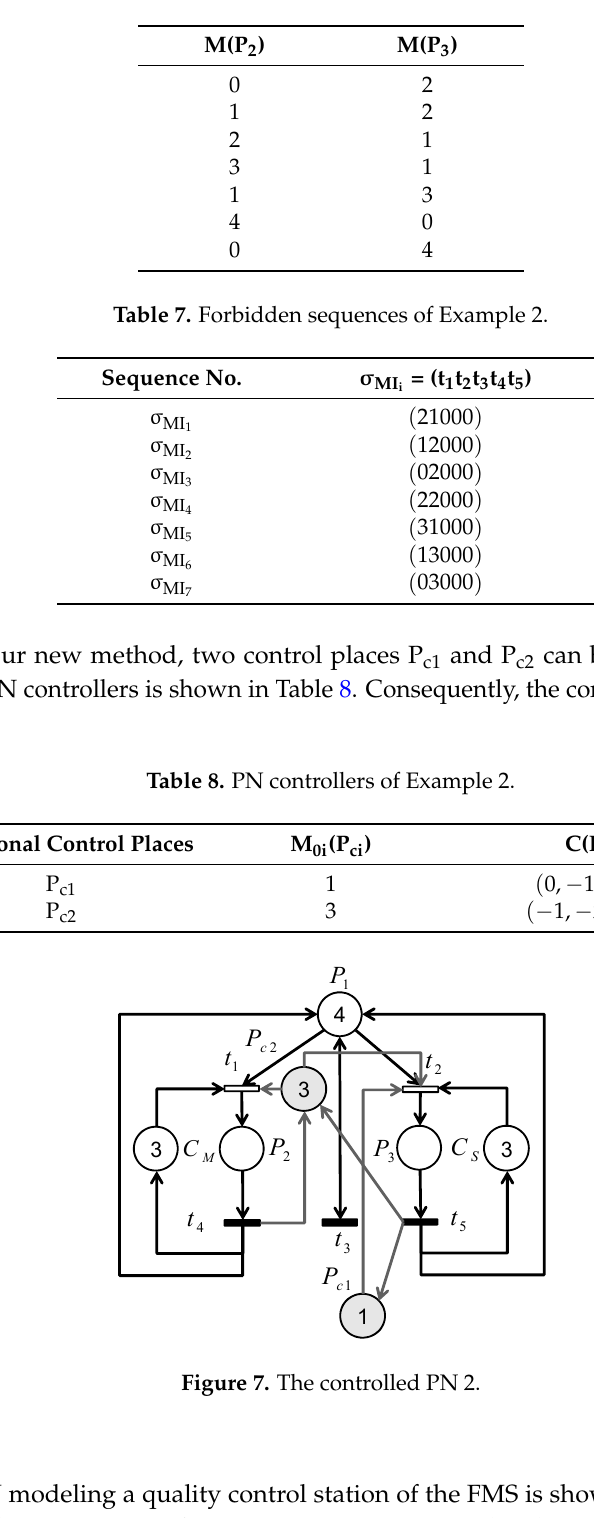
Table 6. Forbidden markings (P 2 P 3 ) of Example 2.